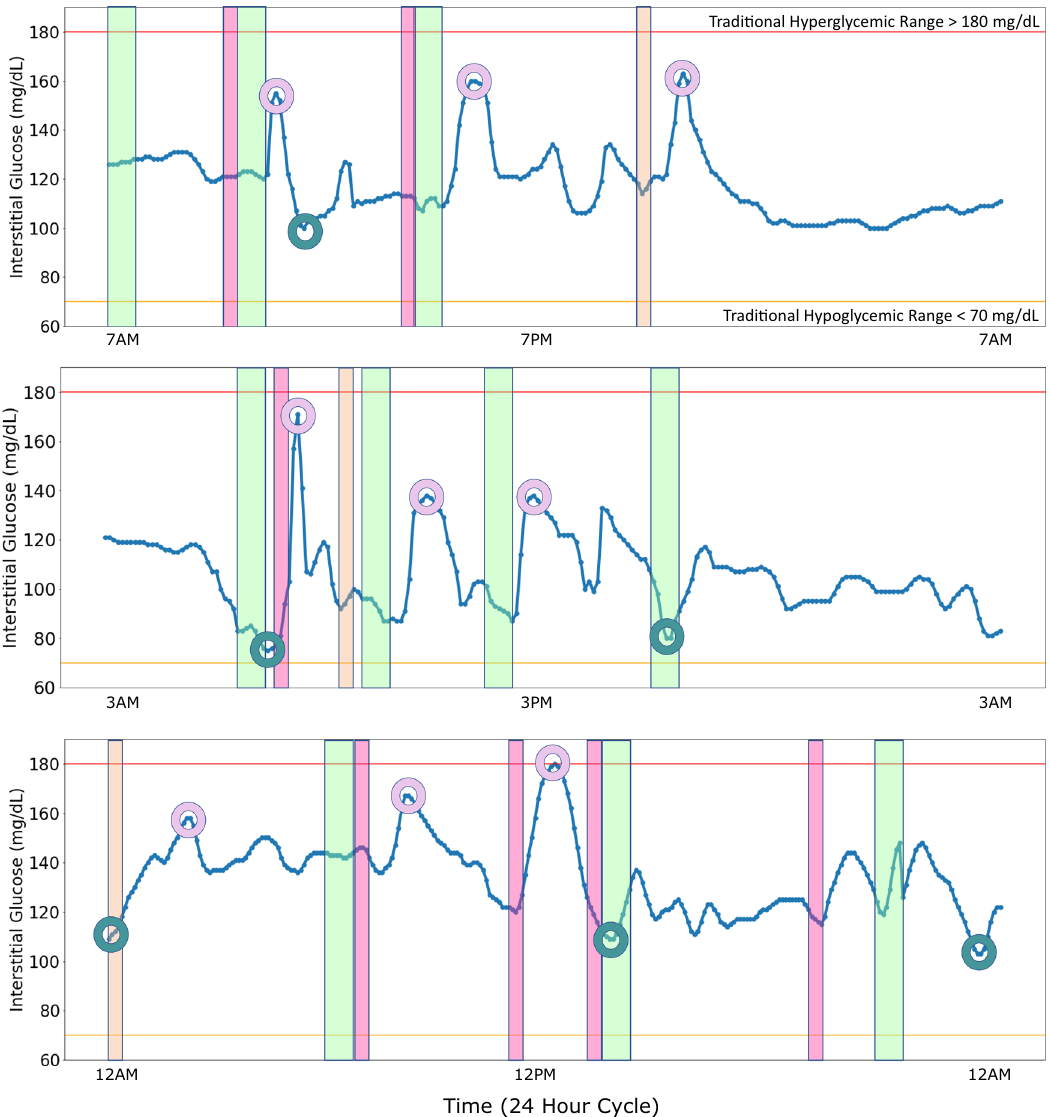
Fig. 2 Case studies of CGM data over 24 h for 3 participants highlighting eating habits and subsequent glucose excursions. Green bands indicate a meal or snack, pink bands indicate consumption of a sugary beverage or soda, and orange bands indicate a sugary snack or dessert. Shown in red is the traditional hyperglycemic range (>180 mg/dL) and shown in yellow is the traditional hypoglycemic range (<70 mg/dL). Note that the participants do not exceed the traditional de fi nitions of glucose excursions. A system that would alert prediabetes patients based on traditional de fi nitions of glucose excursions would be inadequate in these cases. The personalized classi fi cations we propose in this paper would better inform prediabetes patients so they can begin to self-manage their diet, exercise, and stress levels based upon this information. As shown, the personalized classes PersHigh (shown in plum) and PersLow (shown in teal) would provide more personalized information about fl uctuating glucose. For example, sugary drinks and snacks result in higher glucose fl uctuations. By reducing the amount and frequency of sugary drinks and snacks, participants would be less likely to experience a glucose